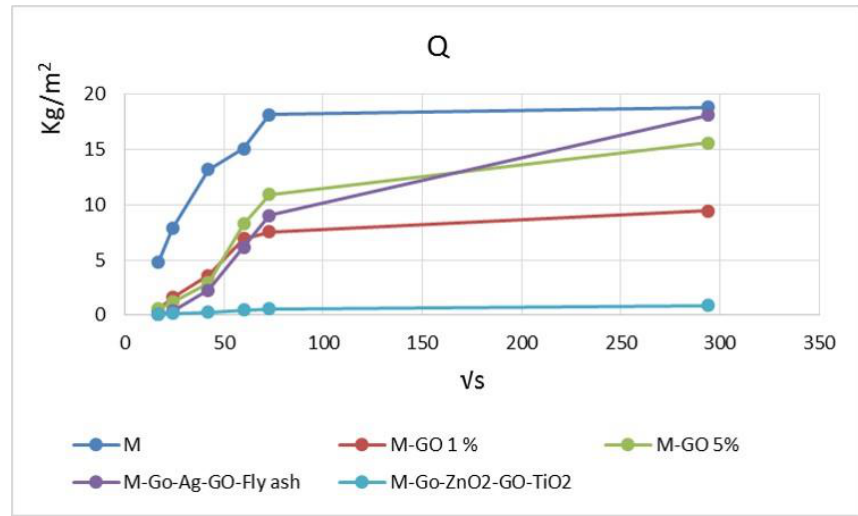
Figure 2. The average water sorption coefficient of the mortars investigated at time (t).